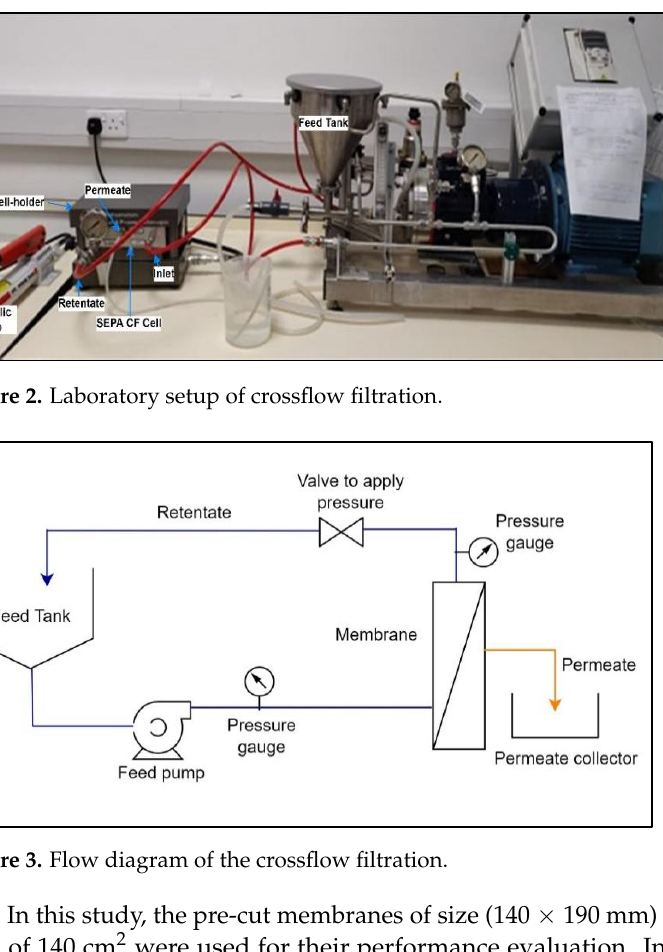
Figure 3. Flow diagram of the crossflow filtration.